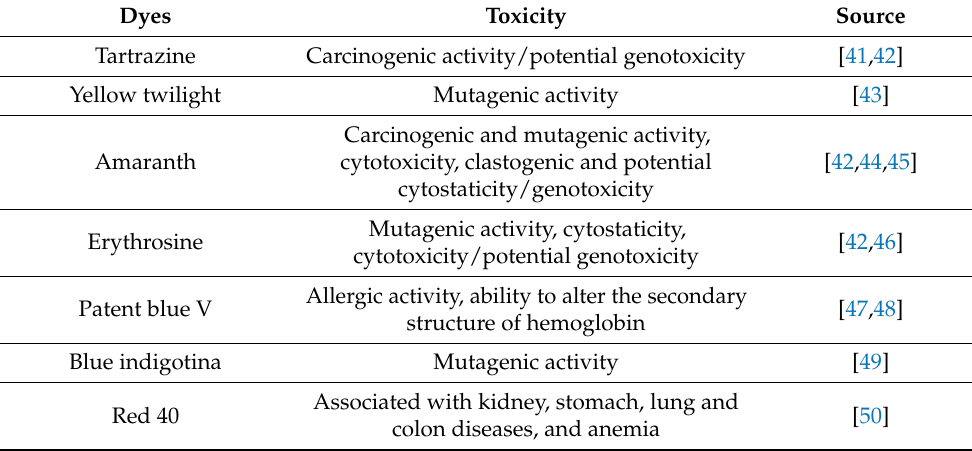
Table 1. Scientific reports on the toxicity of synthetic